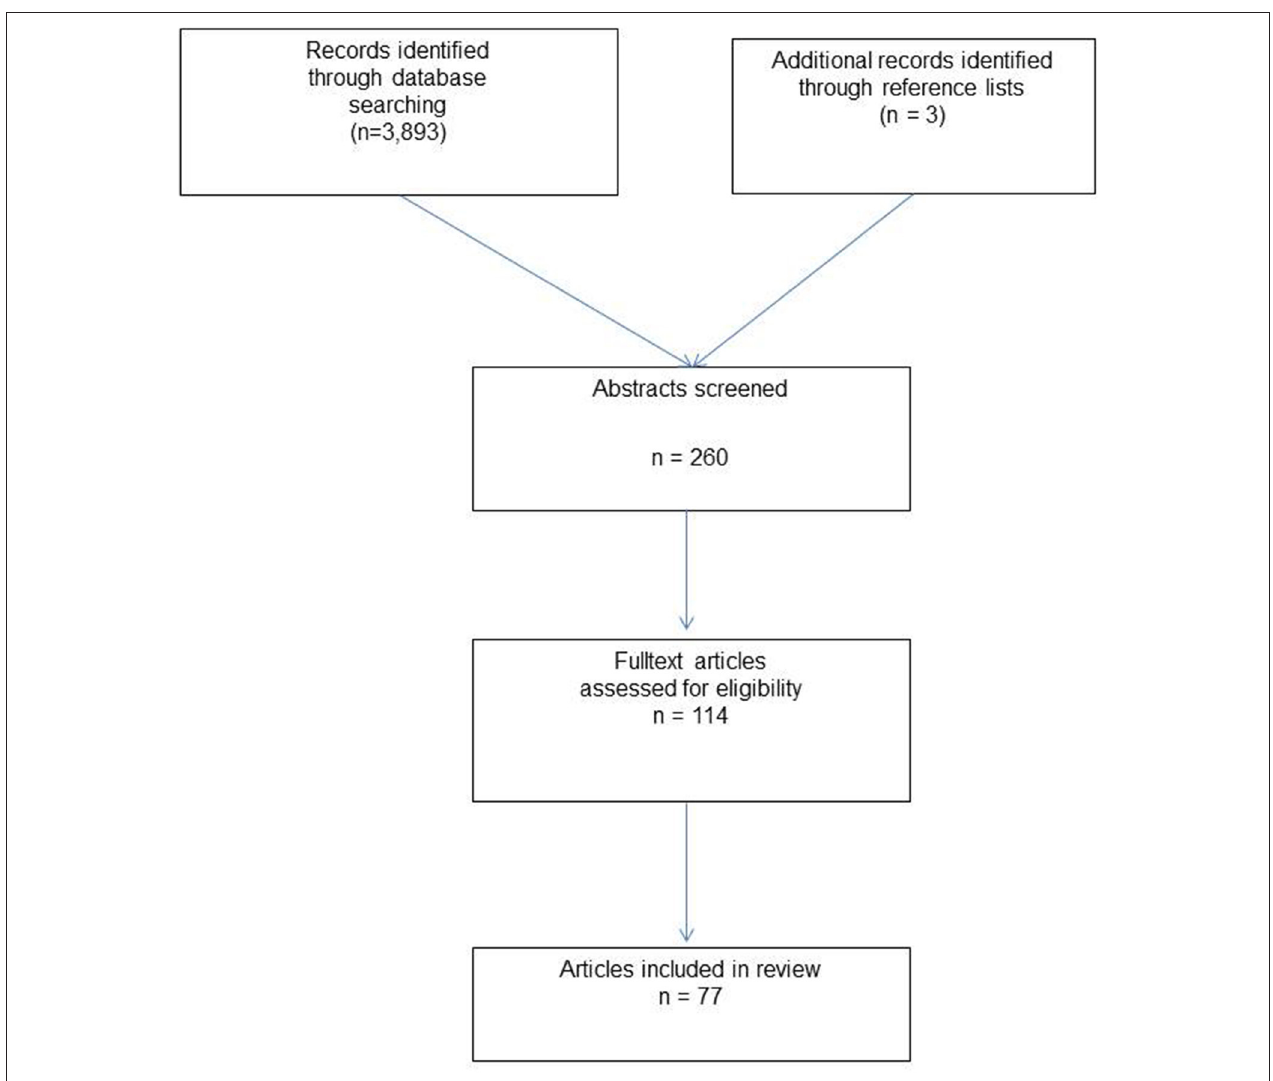
FIGURE 1 | Flowchart of article